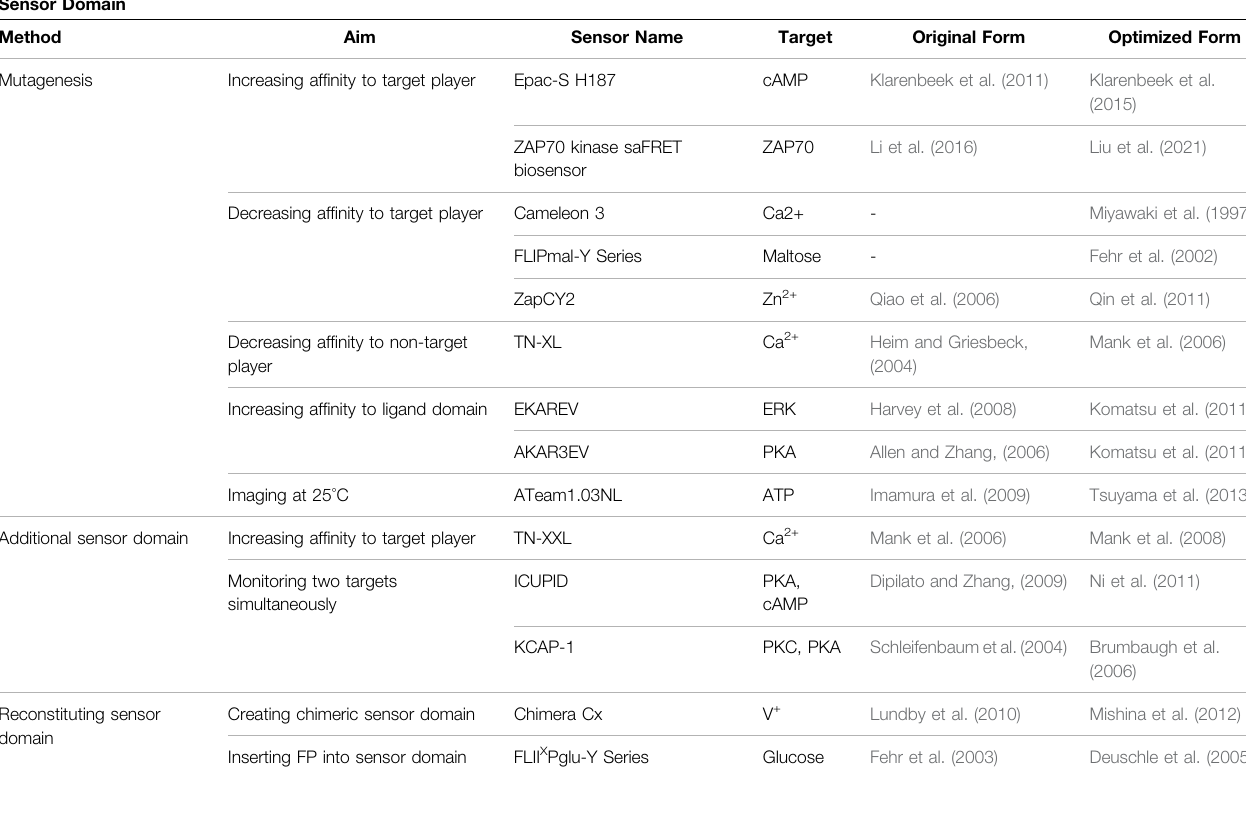
TABLE 1 | Summary of sensor domain optimization